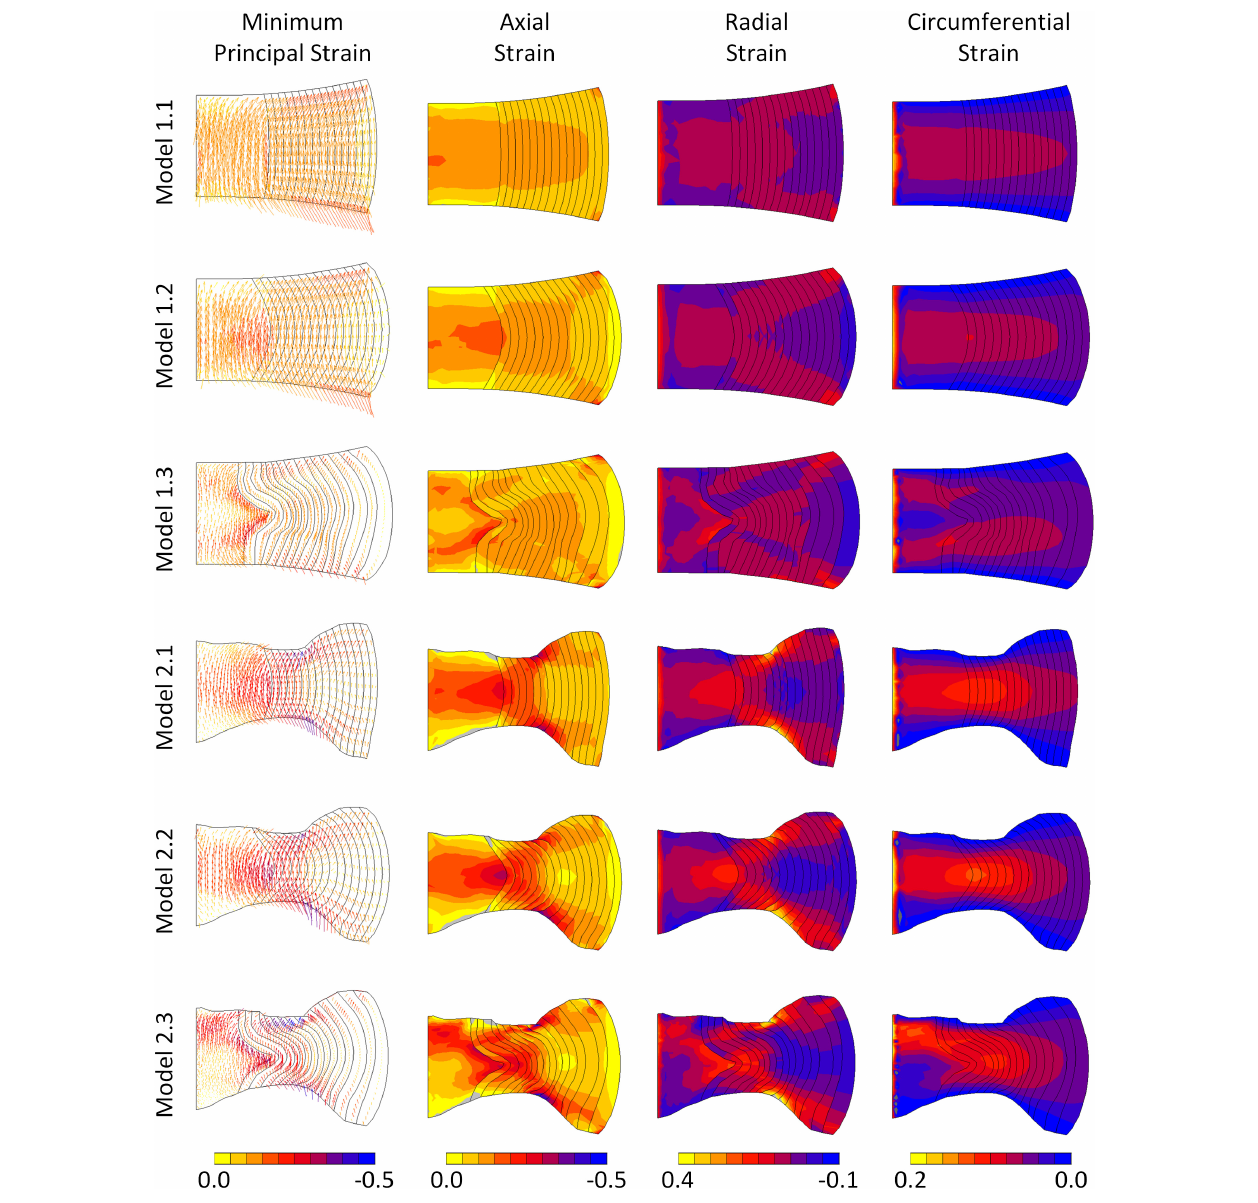
FIGURE 5 | Minimum principal, axial, radial, and circumferential strain distributions in each of the six models at maximum displacement. Vectors in the left column indicate minimum principal strain directions and the colours refer to magnitudes of the minimum principal strains.